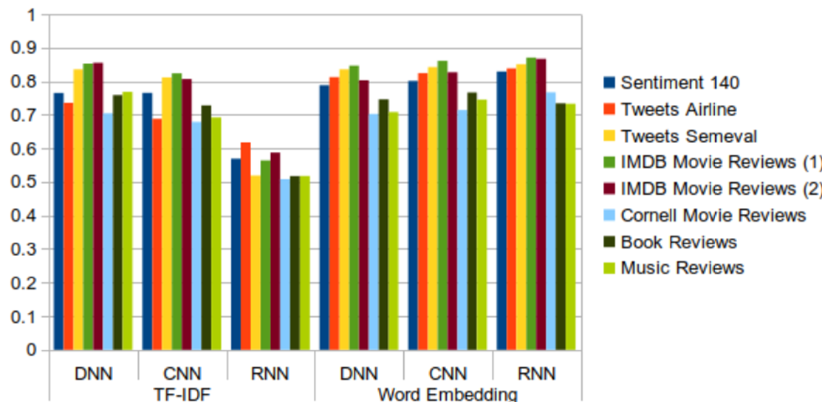
Figure 20. AUC values of DNN, CNN, and RNN models with TF-IDF and word embedding for different datasets.